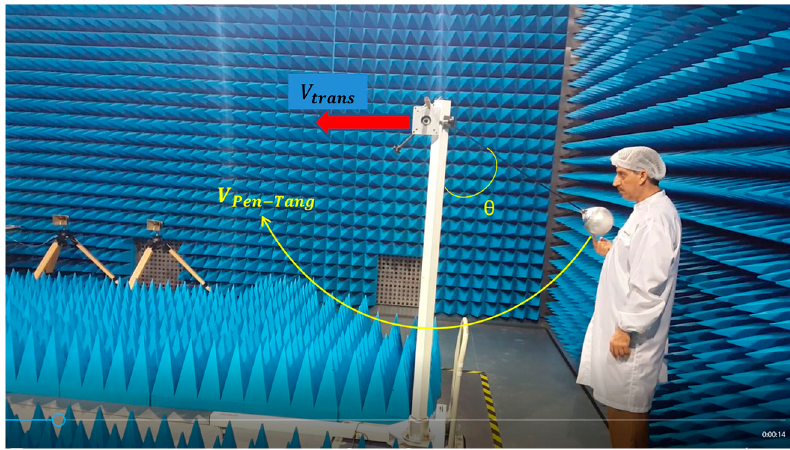
Figure 15. Experimental geometry for forward swinging pendulum.